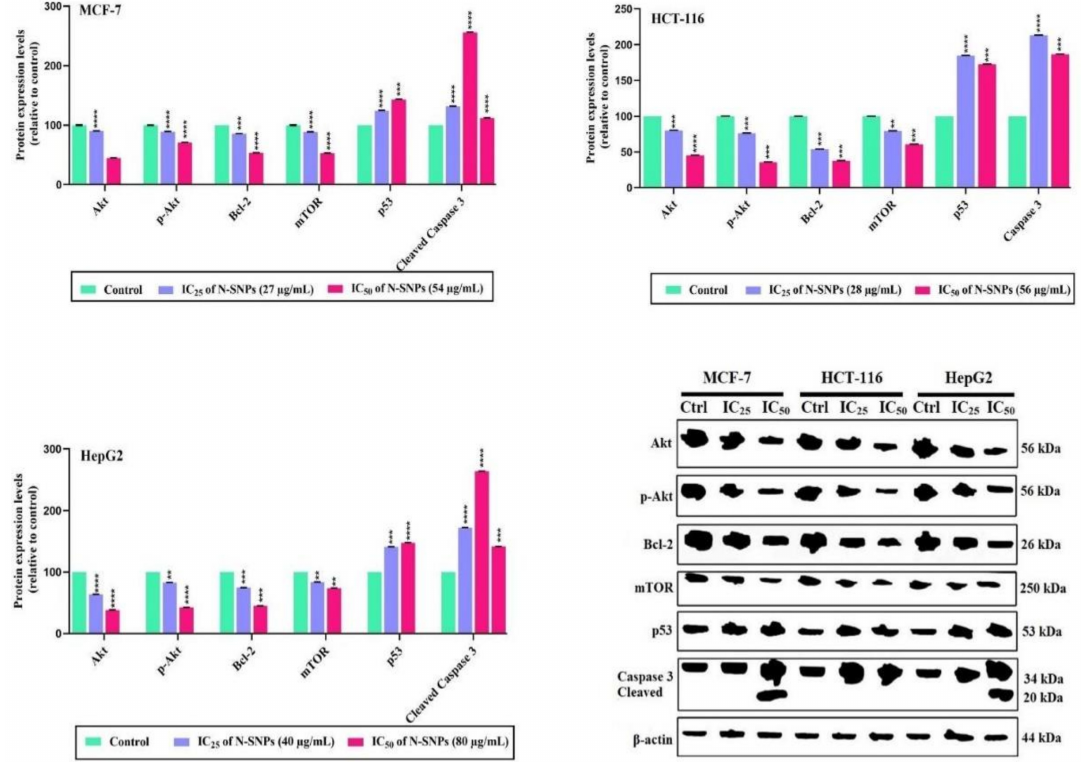
Figure 11. E ff ects of N-SNPs (IC 25 and IC 50 ) on antiapoptotic (protein kinase B (Akt), phosphorylated-Akt (p-Akt), B-cell lymphoma 2 (Bcl-2) and mammalian target of rapamycin (mTOR)) and apoptotic (tumor suppressor (p53) and caspase 3) protein expression levels in MCF-7, HCT-116, and HepG2 cells. All of the data were collected from independent experiments performed in triplicate and are presented as mean ± SEM. p -values were calculated versus untreated cells: **** p < 0.0001, *** p < 0.0003, ** p <